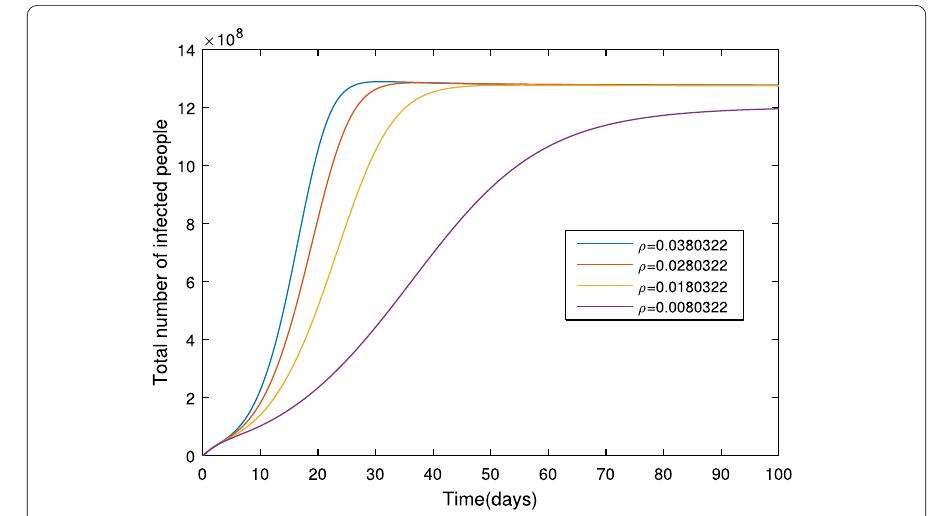
Figure 6 The total number of infected people for various values of ρ